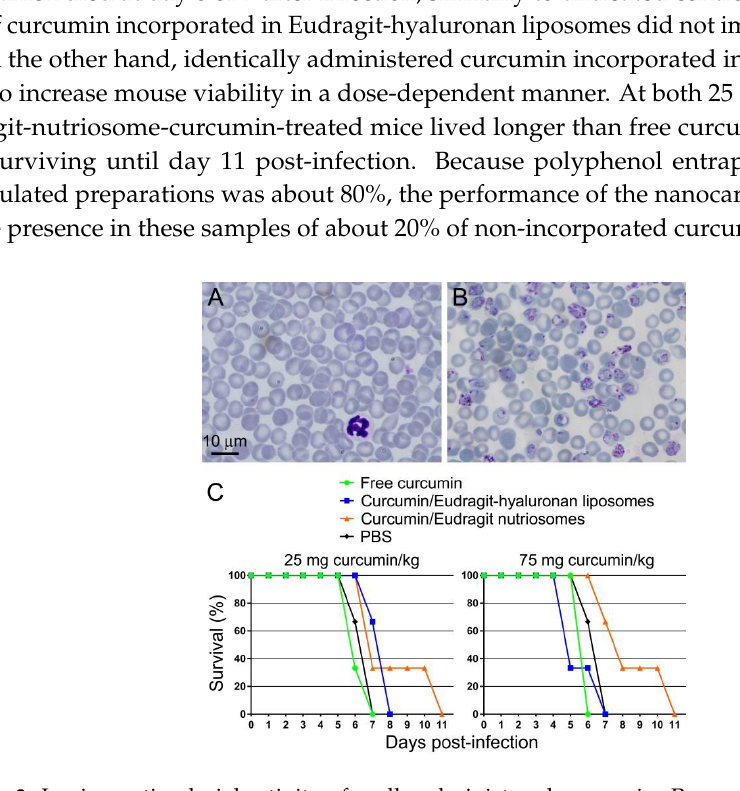
Figure 3. In vivo antimalarial activity of orally administered curcumin. Representative microscope images of blood smears from ( A ) non-infected and ( B ) P. yoelii -infected mice. ( C ) Kaplan-Meier plot for the in vivo assay of the effect on P. yoelii -infected mice ( n = 3 animals/sample) of free or incorporated curcumin administered orally at 25 and 75 mg · kg −1 · day −1 .